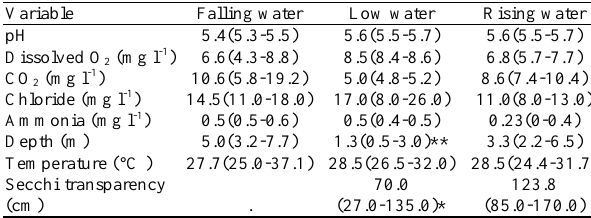
Table 1. Mean (and range) of environmental variables re- corded during three seasons in Taraira Lake. Values